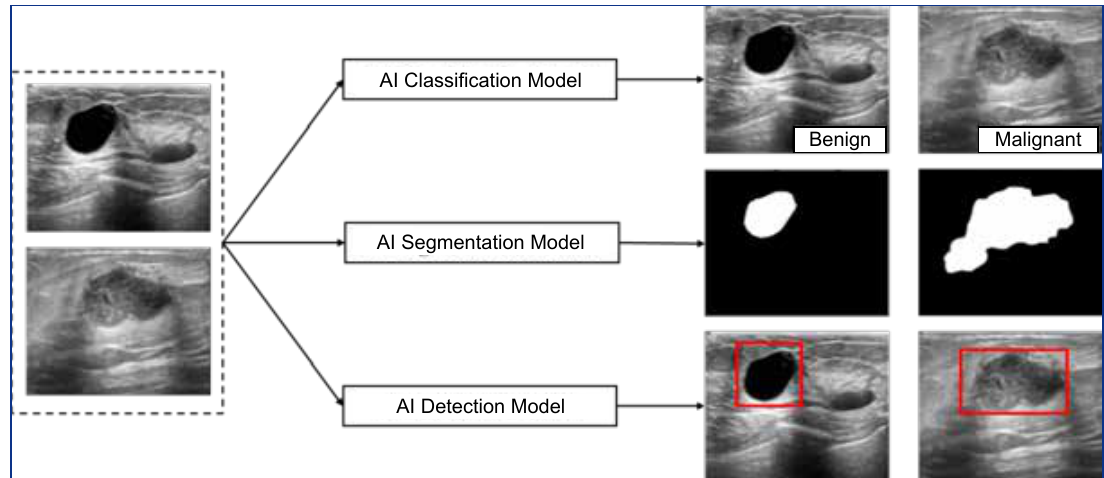
Figure 3 Application flow of AI model in ultrasound image classification, segmentation and detection. Take breast ultrasound images as an example, the image data is from Al-Dhabyani et al. [6].